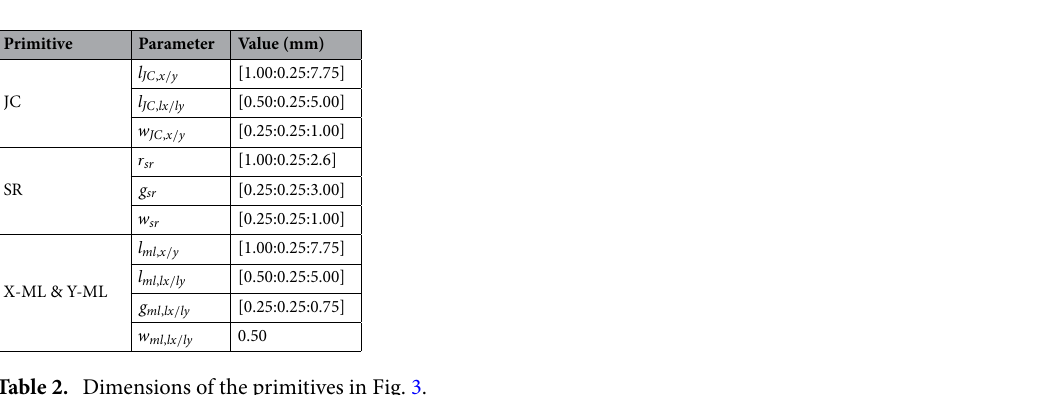
Table 2. Dimensions of the primitives in Fig.